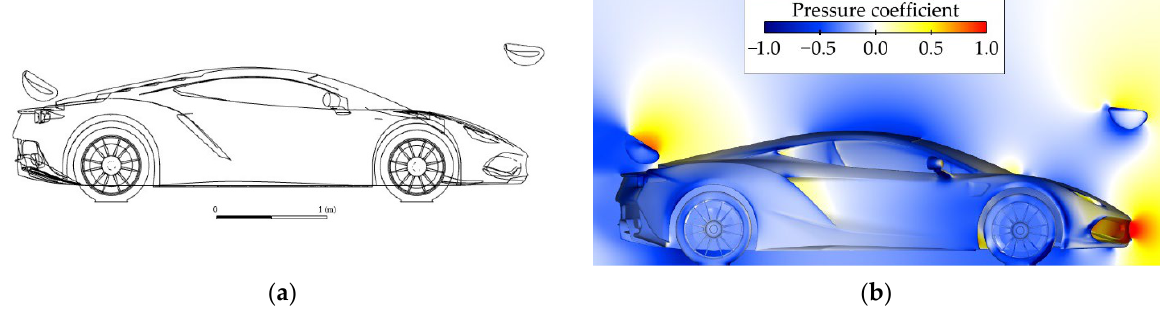
Figure 38. An attempt at balancing the car with a larger spoiler: ( a ) outline of the geometry, side view; ( b ) contours of the pressure coefficient on the symmetry plane and car body, side view.